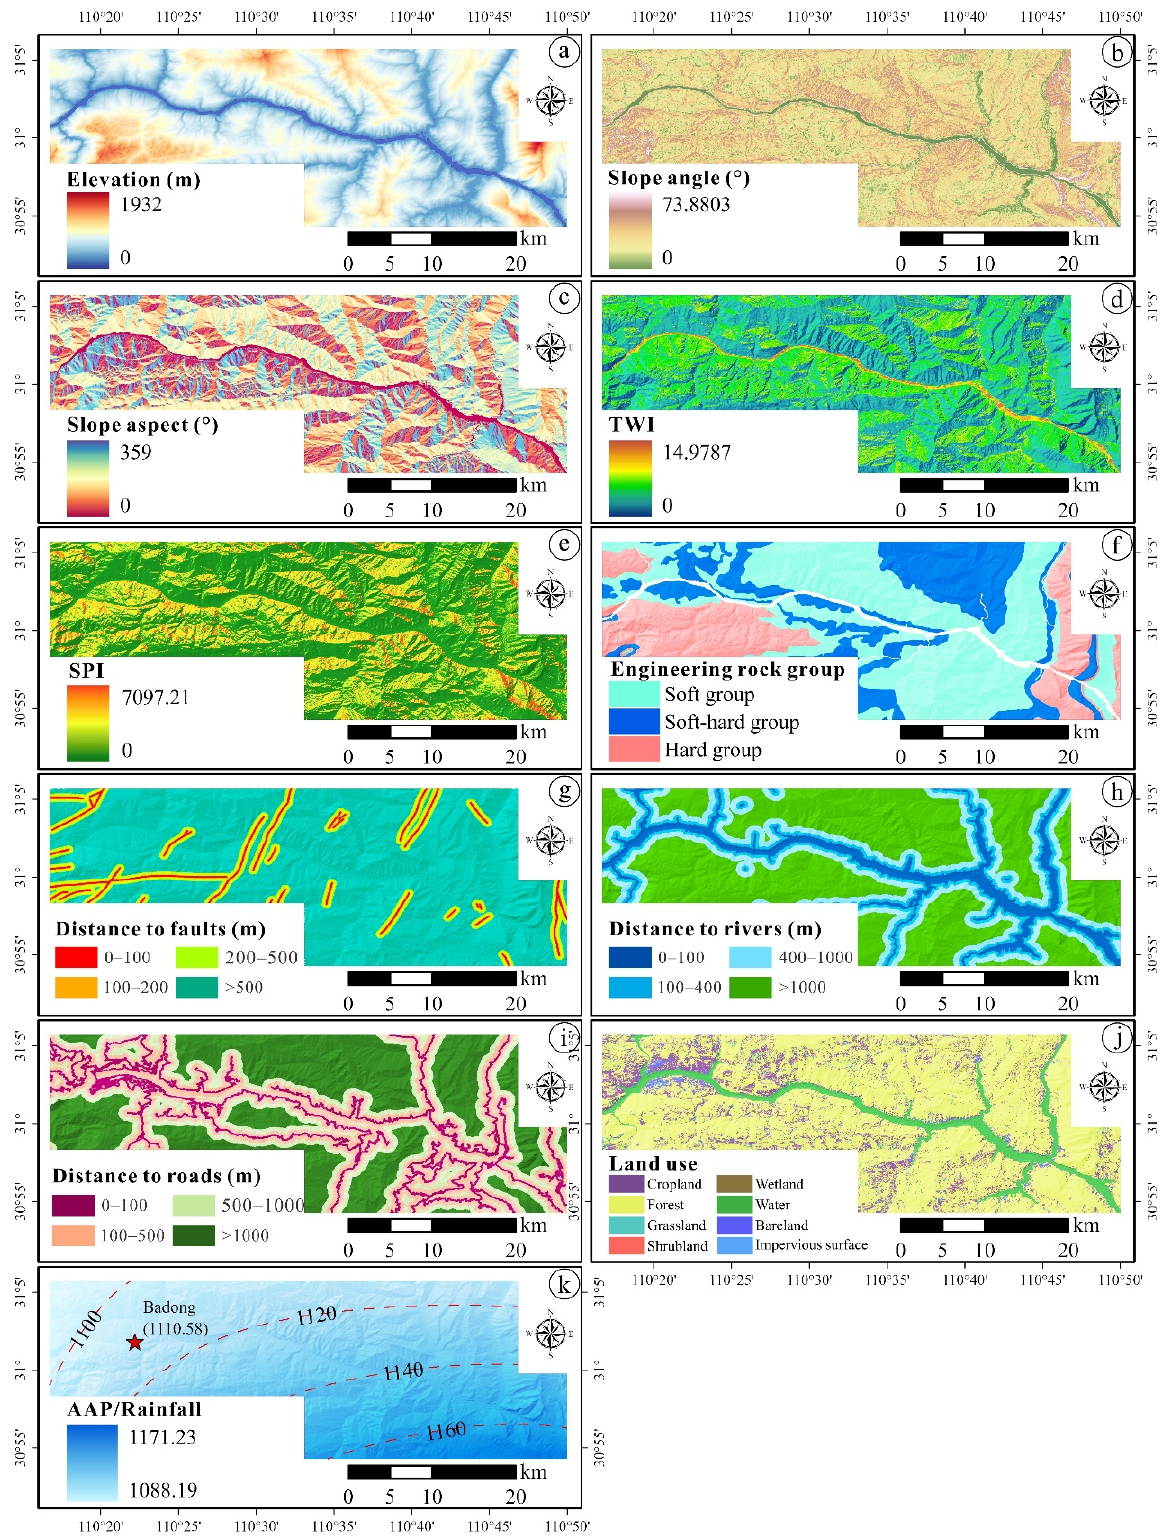
Figure 4. Landslide influencing factors. ( a ) Elevation (EV), ( b ) slope angle (SA), ( c ) slope aspect (SAP), ( d ) topographic wetness index (TWI), ( e ) stream power index (SPI), ( f ) engineering rock group (ERG), ( g ) distance to faults (DF), ( h ) distance to rivers (DRV), ( i ) distance to roads (DRD), ( j ) land use (LU), ( k ) average annual precipitation (AAP).